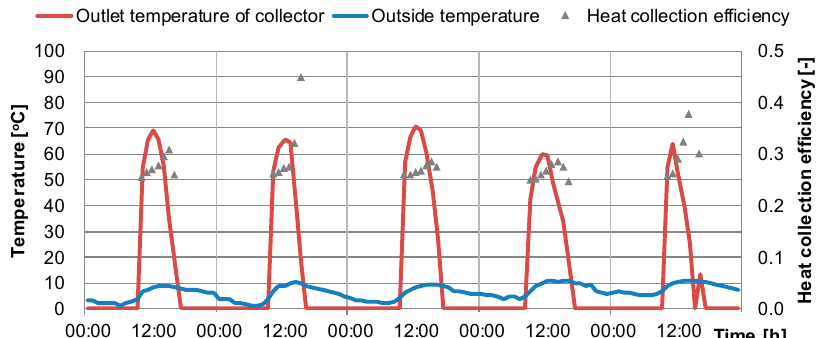
Figure 13. Outlet temperature of the collector and heat collector efficiency of the air-based solar system.